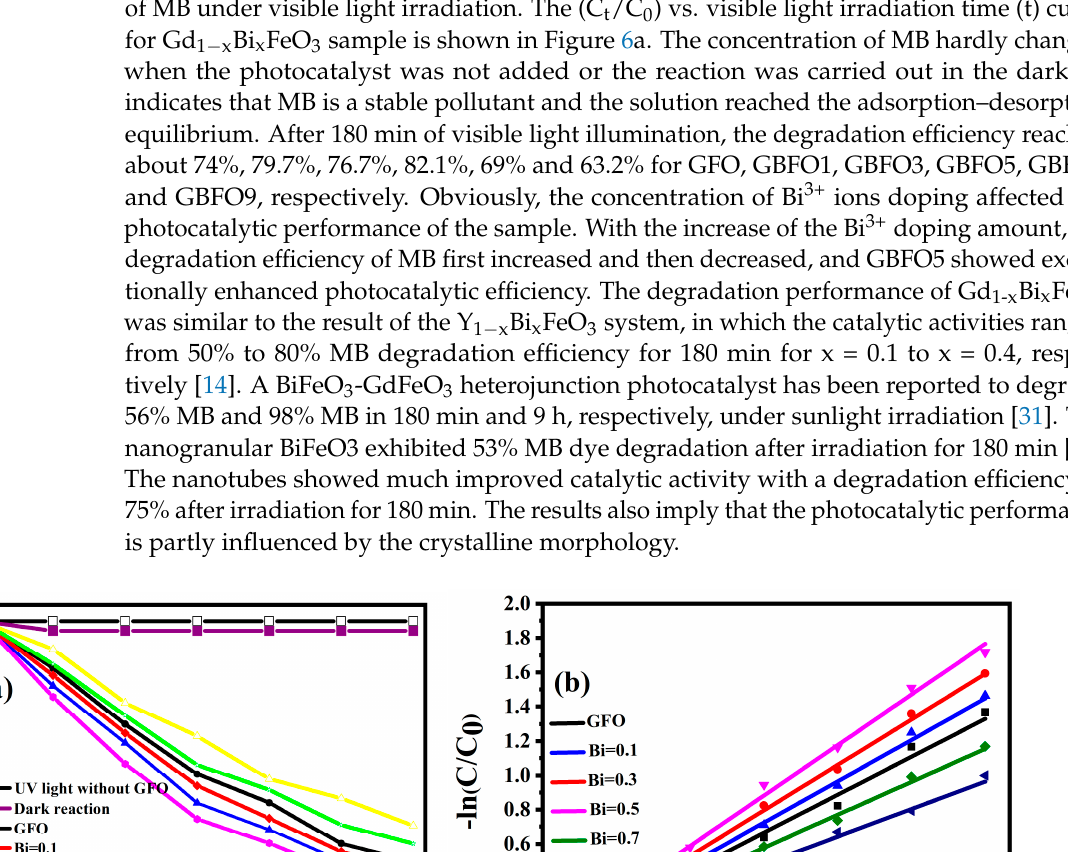
x Bi x FeO 3 as a catalyst; ( b ) pseudo- − x Bi x FeO 3 −